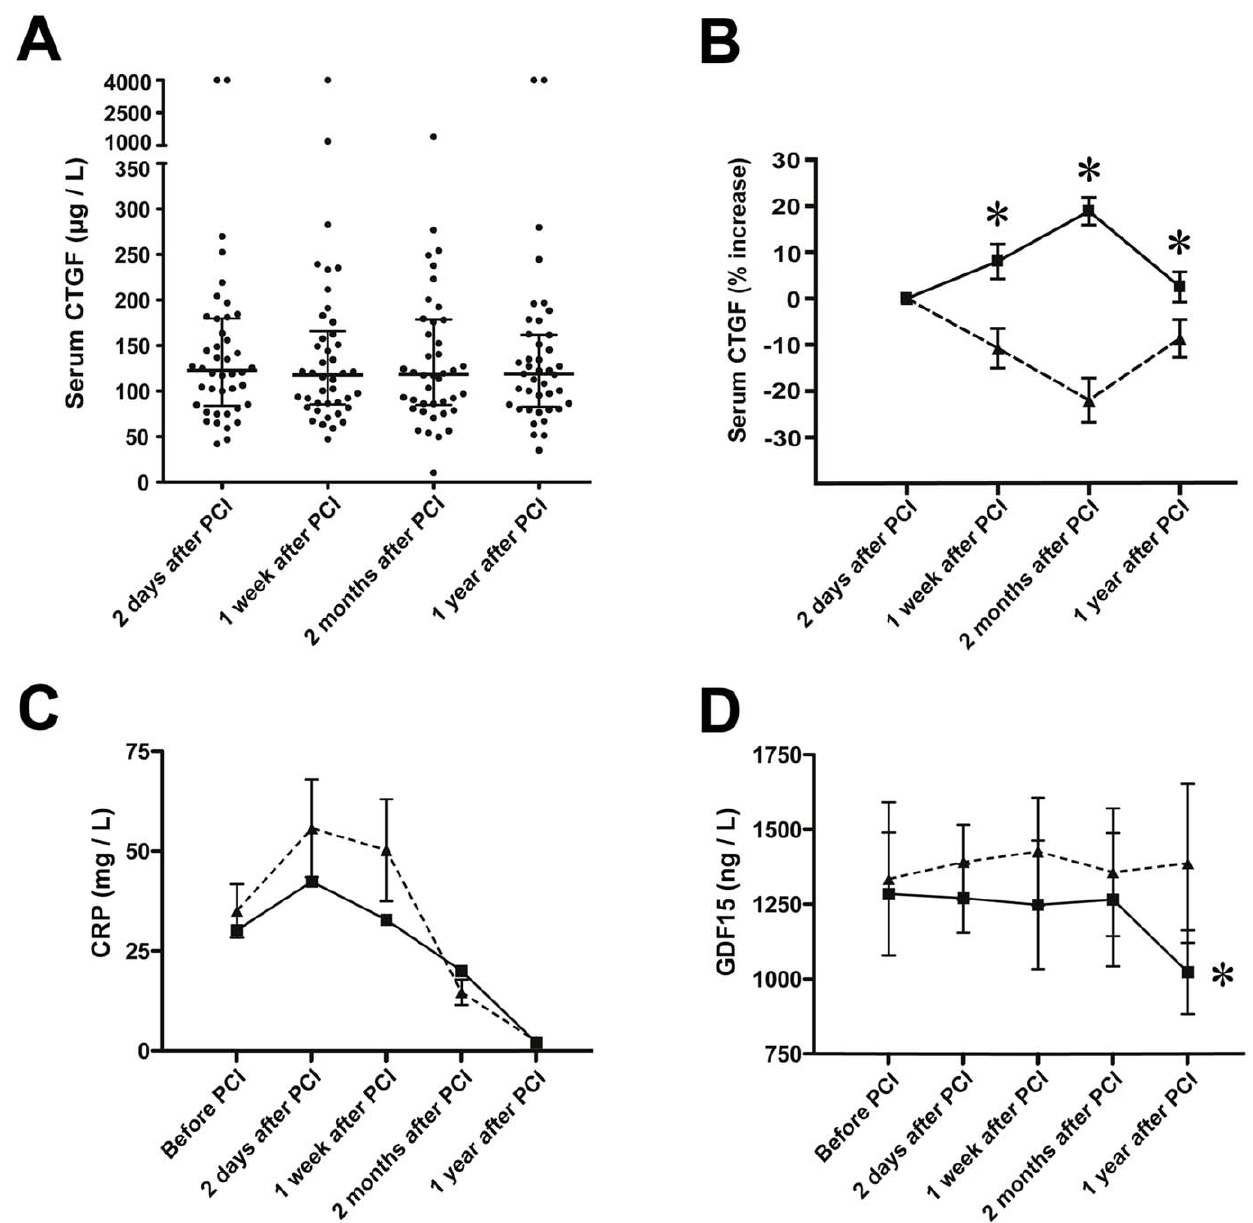
Figure 8. Serum levels of CTGF, CRP and GDF-15 in patients after myocardial infarction. A. Scatter-plot of serum CTGF levels at various time points after percutaneous coronary intervention in patients (n=42) admitted for acute ST-elevation MI. Median serum CTGF levels and interquartile range (25 th to 75 th percentile) at each time point are indicated. B. Time course of s-CTGF levels after stratification of the patient cohort into two groups: patients that displayed increase in s-CTGF levels after MI ( & ; n=21), and patients in which s-CTGF levels remained unaltered or declined after MI ( m ; n=21). The figure demonstrates s-CTGF levels plotted as percent change from day 2 after PCI for each time point during the one-year follow-up after MI. Values are mean 6 SEM. * P , 0.05 between groups. C–D. Panels demonstrating serial measurements of serum levels of CRP and GDF-15 in the two patient groups. Values are mean 6 SEM. * P , 0.01 for intra-group comparisons.